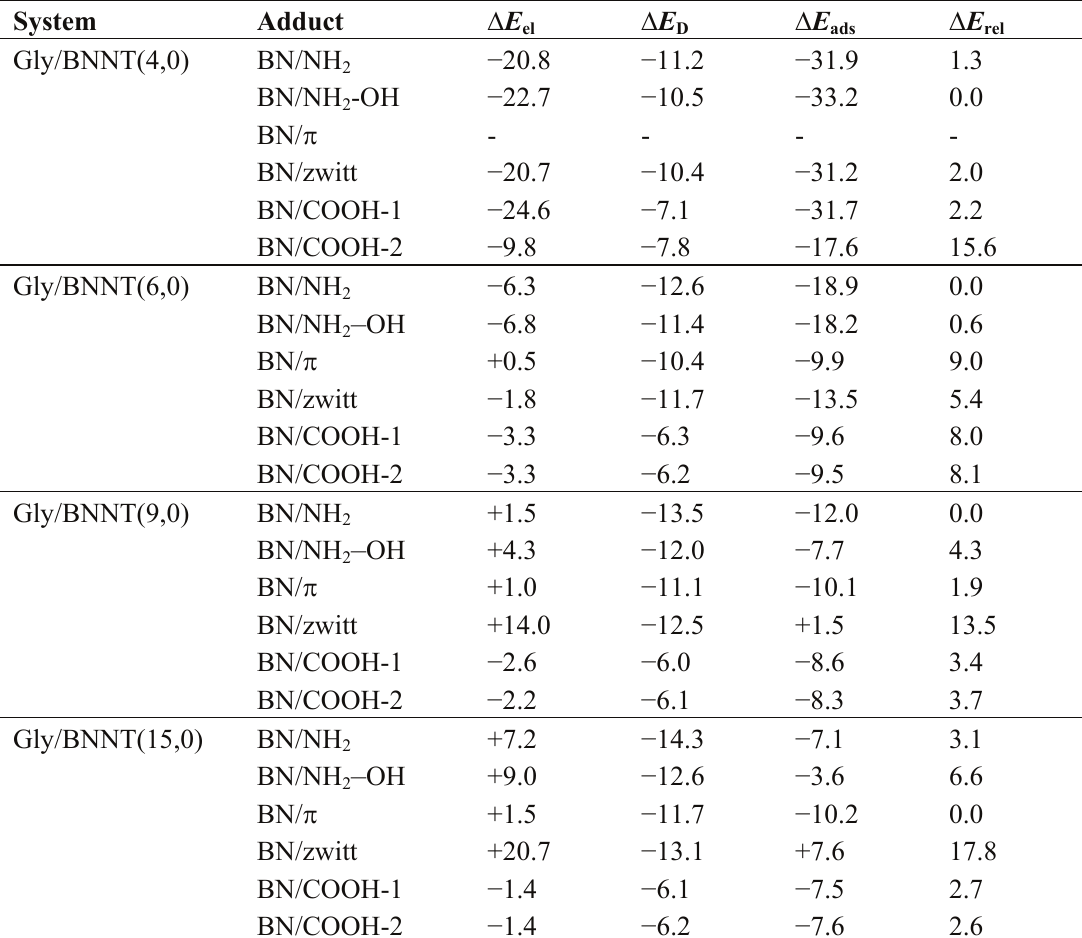
Table 1. Calculated adsorption energies ( ∆ E energy contribution ( ∆ E ) and the contribution of dispersion ( ∆ E el energies ( ∆ E ) for a given Gly/BNNT system are also included. Values in units of rel kcal mol − 1